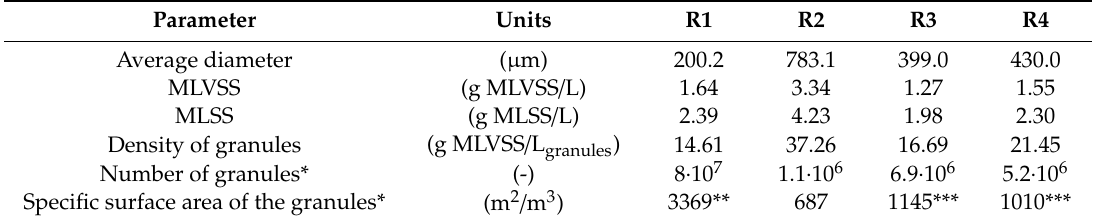
Table 2. Comparison of biomass in reactors on the 89th day of the experiment. Parameter Units R1 R2 R3 R4 Average diameter ( µ m) 200.2 783.1 399.0 430.0 MLVSS (g MLVSS / L) 1.64 MLSS (g MLSS / L) Density of granules (g MLVSS / L granules ) 14.61 Number of granules* (-) 8 · 10 7 (m 2 / m 3 )